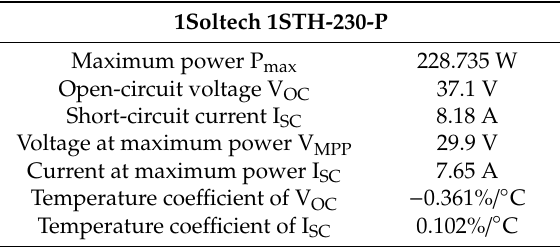
Table 4. Second system—PV panel characteristics under